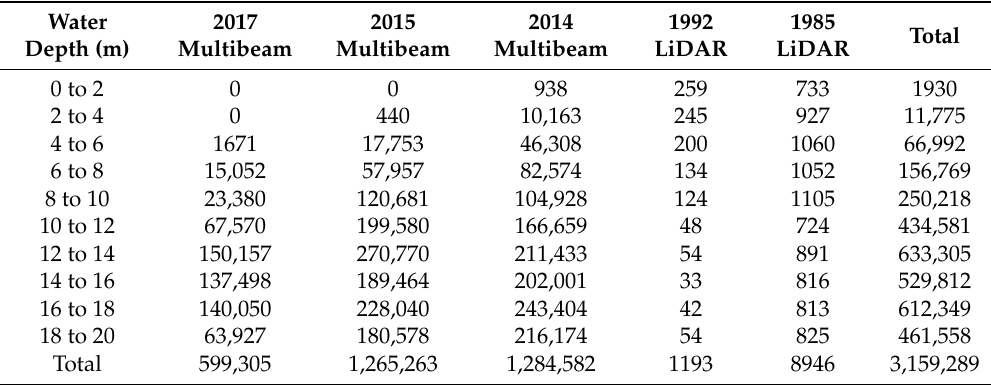
Table 2. Distribution of survey points for water depth